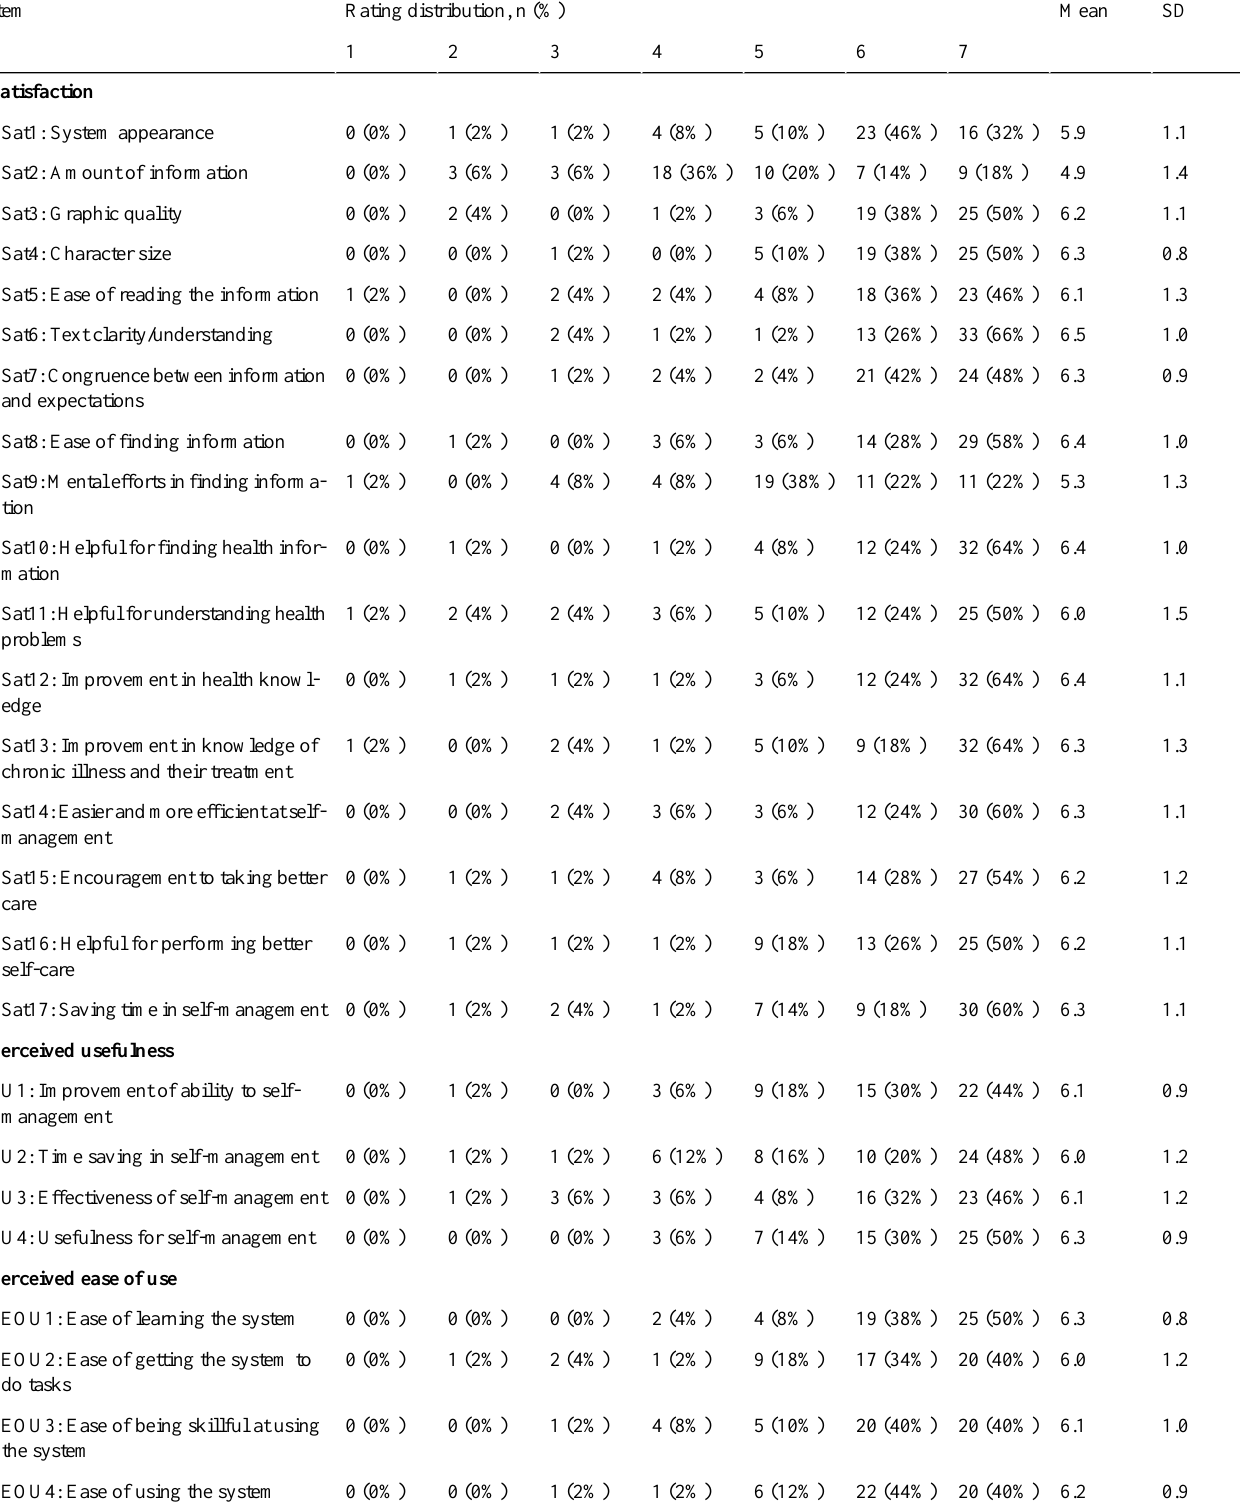
Table 7. Descriptive statistics for satisfaction, perceived usefulness, and ease of use items (1 = negative to 7 = positive). SDMeanRating distribution, n